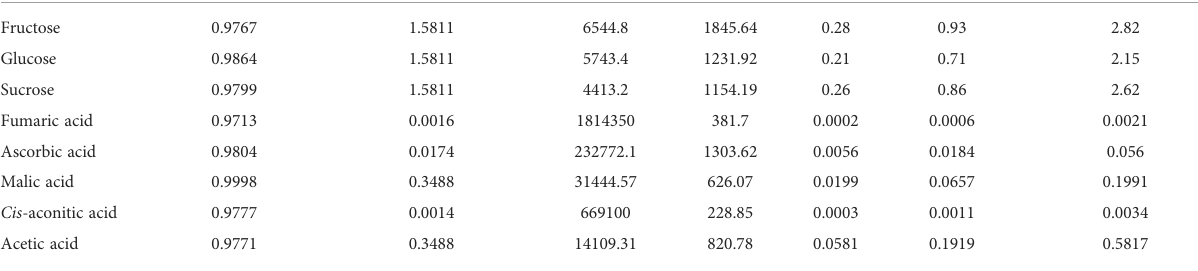
TABLE 1 Validation parameters for HPLC/UPLC